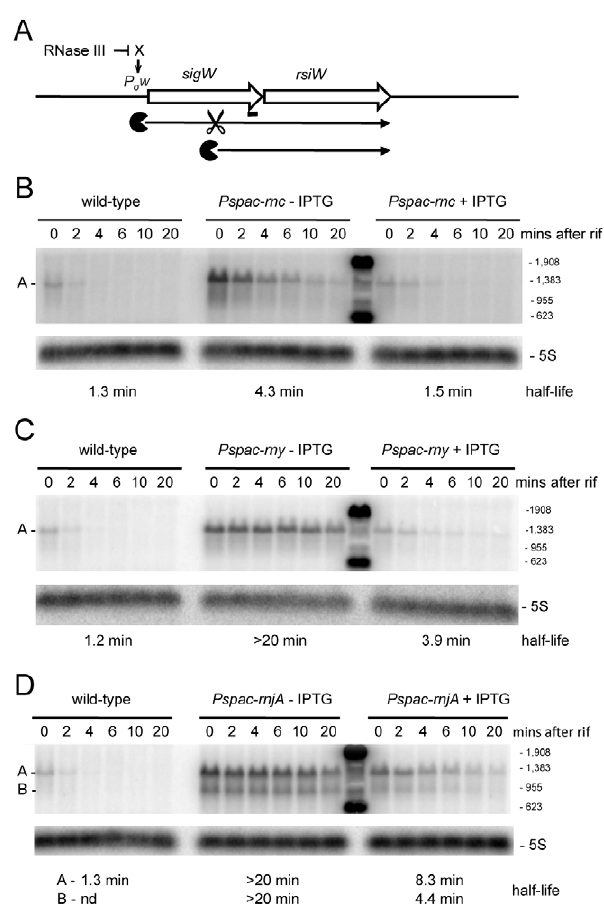
Figure 7. Degradation of the sigW-rsiW mRNA depends on RNase Y and RNase J1, while its transcription is dependent on RNase III. (A) Structure and predicted degradation pathway of the sigW-rsiW transcript. ORFs are shown as large white arrows, transcripts as thin black arrows. Scissors indicate cleavage by RNase Y, ‘Pacman’ symbols represent 5 9 -3 9 degradation by RNase J1. A short thick line indicates the position of the probe used. P s W indicates the approximate promoter position and relevant sigma factor mapped in [31,32]. The schematic also depicts RNase III initiated degradation of a transcript encoding an unknown factor X early in the SigW cascade. (B) Northern blot of total mRNA isolated at times after addition of rifampicin (rif) from wild-type and RNase III depleted ( Pspac-rnc 2 IPTG) and RNase III induced ( Pspac-rnc + IPTG) cells. The blot was probed with 5 9 -labeled oligo CCB900 (Table S6) and reprobed with oligo HP246 against 5S rRNA. The half-life of the sigW-rsiW transcript is given under the Northern blot. Migration positions of RNA markers are shown to the right of the blot. Cross-hybridization to the marker is visible in the lane between the ( 2 ) and ( + ) IPTG samples. (C) Northern blot of total mRNA isolated at times after addition of rifampicin (rif) from wild-type and RNase Y depleted ( Pspac-rny 2 IPTG) and RNase Y induced ( Pspac- rny + IPTG) cells. Description as in panel (B). (D) Northern blot of total mRNA isolated at times after addition of rifampicin (rif) from wild-type and RNase J1 depleted ( Pspac-rnjA 2 IPTG) and RNase J1 induced ( Pspac- rnjA + IPTG) cells. Description as in panel